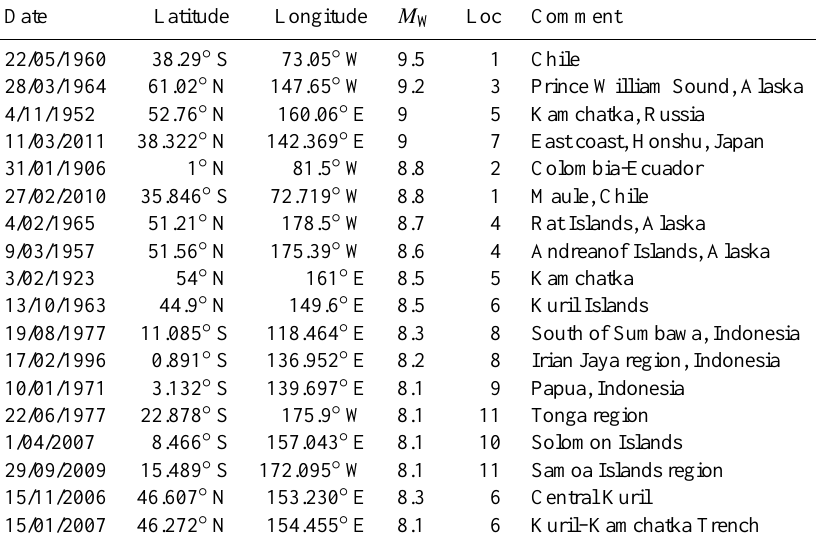
Table 1. The ten largest offshore Pacific earthquakes since 1900 and Southwest Pacific earthquakes of M W = > 8.1 since 1950, in decreasing magnitude. (Data from USGS, see http://earthquake.usgs.gov/earthquakes). The “Loc.” column indicates the approximate location of the epicentres on Fig. 1.